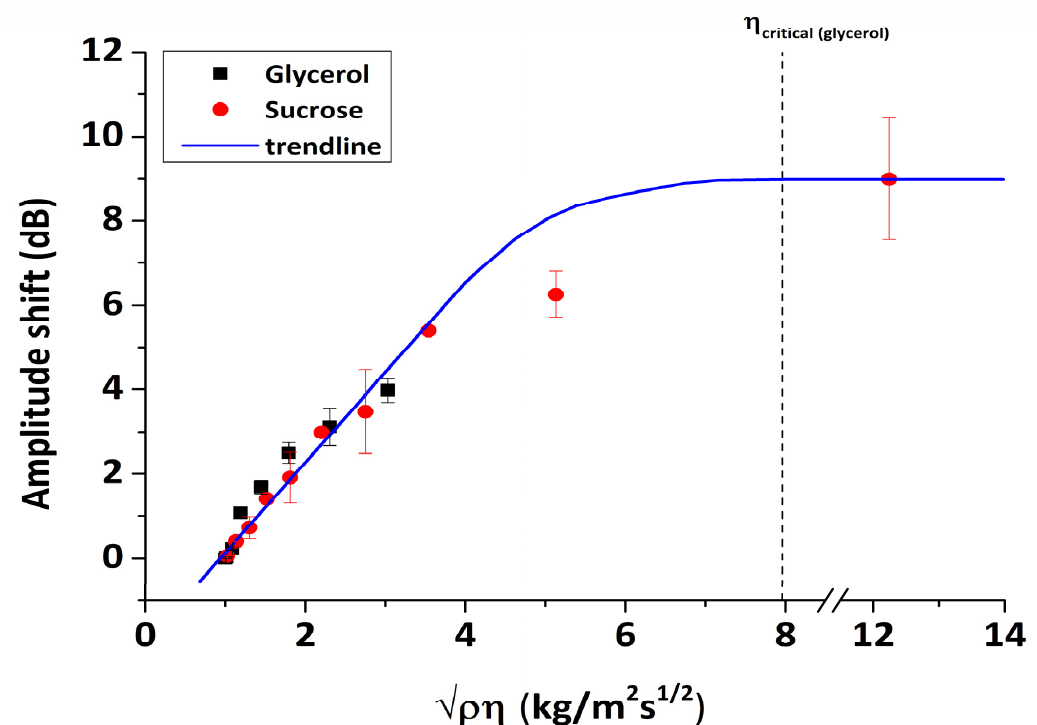
Figure 13. Amplitude response (normalized to water) versus the square root of the density–viscosity product for glycerol/water and sucrose/water solutions.